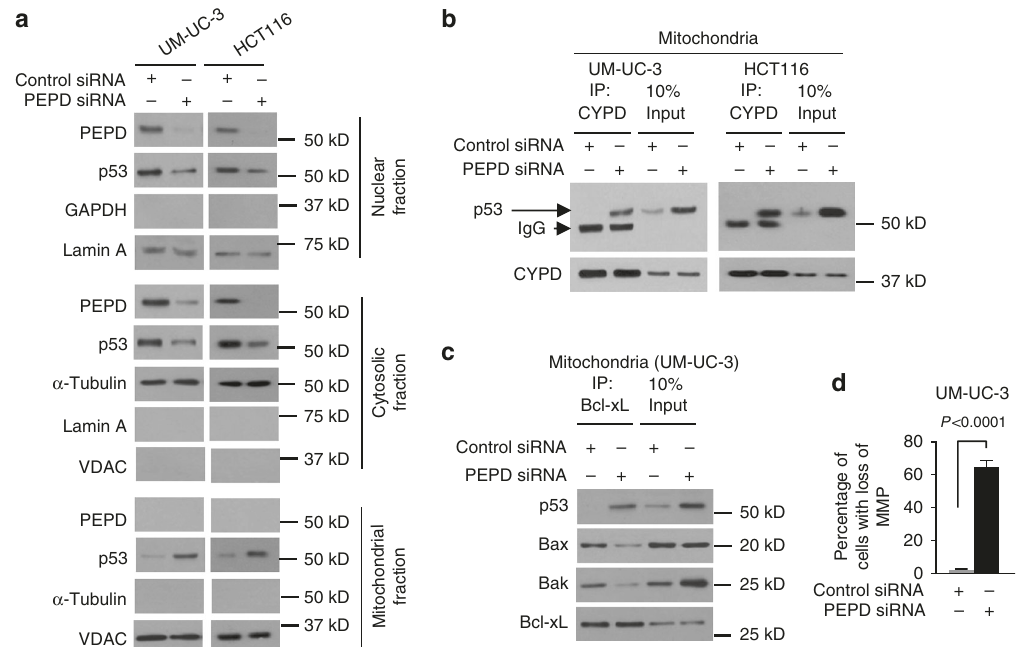
Fig. 3 PEPD inhibits transcription-independent p53 activity. a IB analysis of p53 relocation in cells after siRNA treatment for 72 h. Lamin A, α -tubulin and VDAC were measured to ensure the purity of the subcellular fractions or as loading controls. b IB analysis of p53 binding to CYPD in mitochondria after cell treatment with siRNA for 72 h. c IB analysis of Bcl-xL binding to p53, Bax and Bak in mitochondria after cell treatment with siRNA for 72 h. d Flow cytometry analysis of MMP after cell treatment with siRNA for 72 h. Cells were cultured in 6-well plates (5 – 10 × 10 4 cells/well) for 24 h before experimental treatment. Data are means ± s.d. ( n =